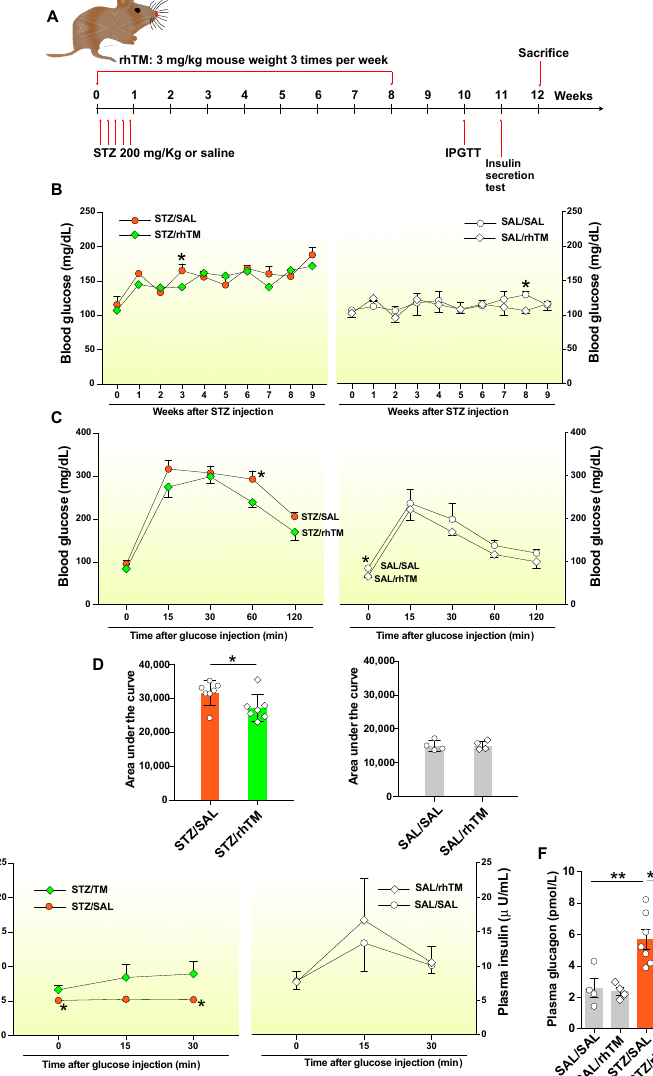
Figure 1. Treatment of diabetic mice with recombinant human thrombomodulin improved glucose tolerance. ( A ) Mice received intraperitoneal injection of streptozotocin (STZ) for five days and were treated with recombinant human thrombomodulin (rhTM) (STZ/rhTM) or saline (STZ/SAL) three times a week for 8 weeks and then sacrificed at 12 weeks. Non-diabetic mice received intraperitoneal saline and were treated with rhTM (SAL/rhTM) or saline (SAL/SAL) for the same time interval and schedule. ( B ) Blood glucose levels were measured as described in the Materials and Methods every week for 9 weeks. ( C ) Intraperitoneal glucose tolerance test was performed on the 10th week after STZ administration, as described in the Materials and Methods. ( D ) The areas under the curve obtained during intraperitoneal glucose tolerance test were calculated. ( E ) The insulin secretion test was performed on the 11th week after STZ administration, as described in the Materials and Methods. ( F ) Plasma glucagon was measured 15 min after glucose challenge as described in the Methods. Data are the mean ± S.D. Statistical analysis by unpaired t -test and ANOVA with Tukey’s test. * p < 0.05 vs. STZ/rhTM, ** p < 0.01, *** p <